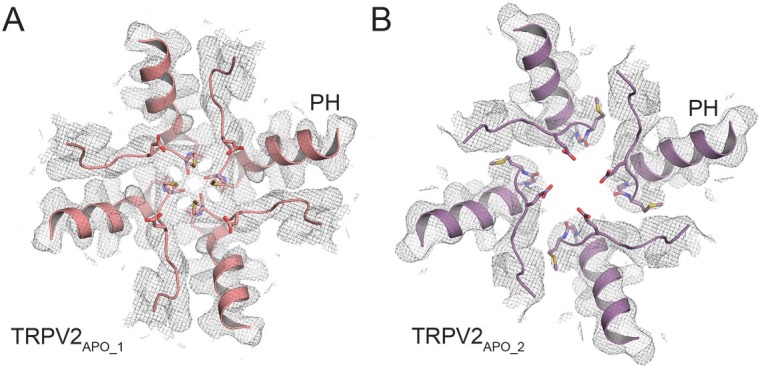
Cryo-EM map density around the selectivity filter of TRPV2APO_1 and TRPV2APO_2.Density for (A) TRPV2APO_1 (salmon) and (B) TRPV2APO_2 (purple) is contoured to σ = 5. The selectivity filter is viewed from the extracellular side of the membrane. Residues of interest are represented as sticks.